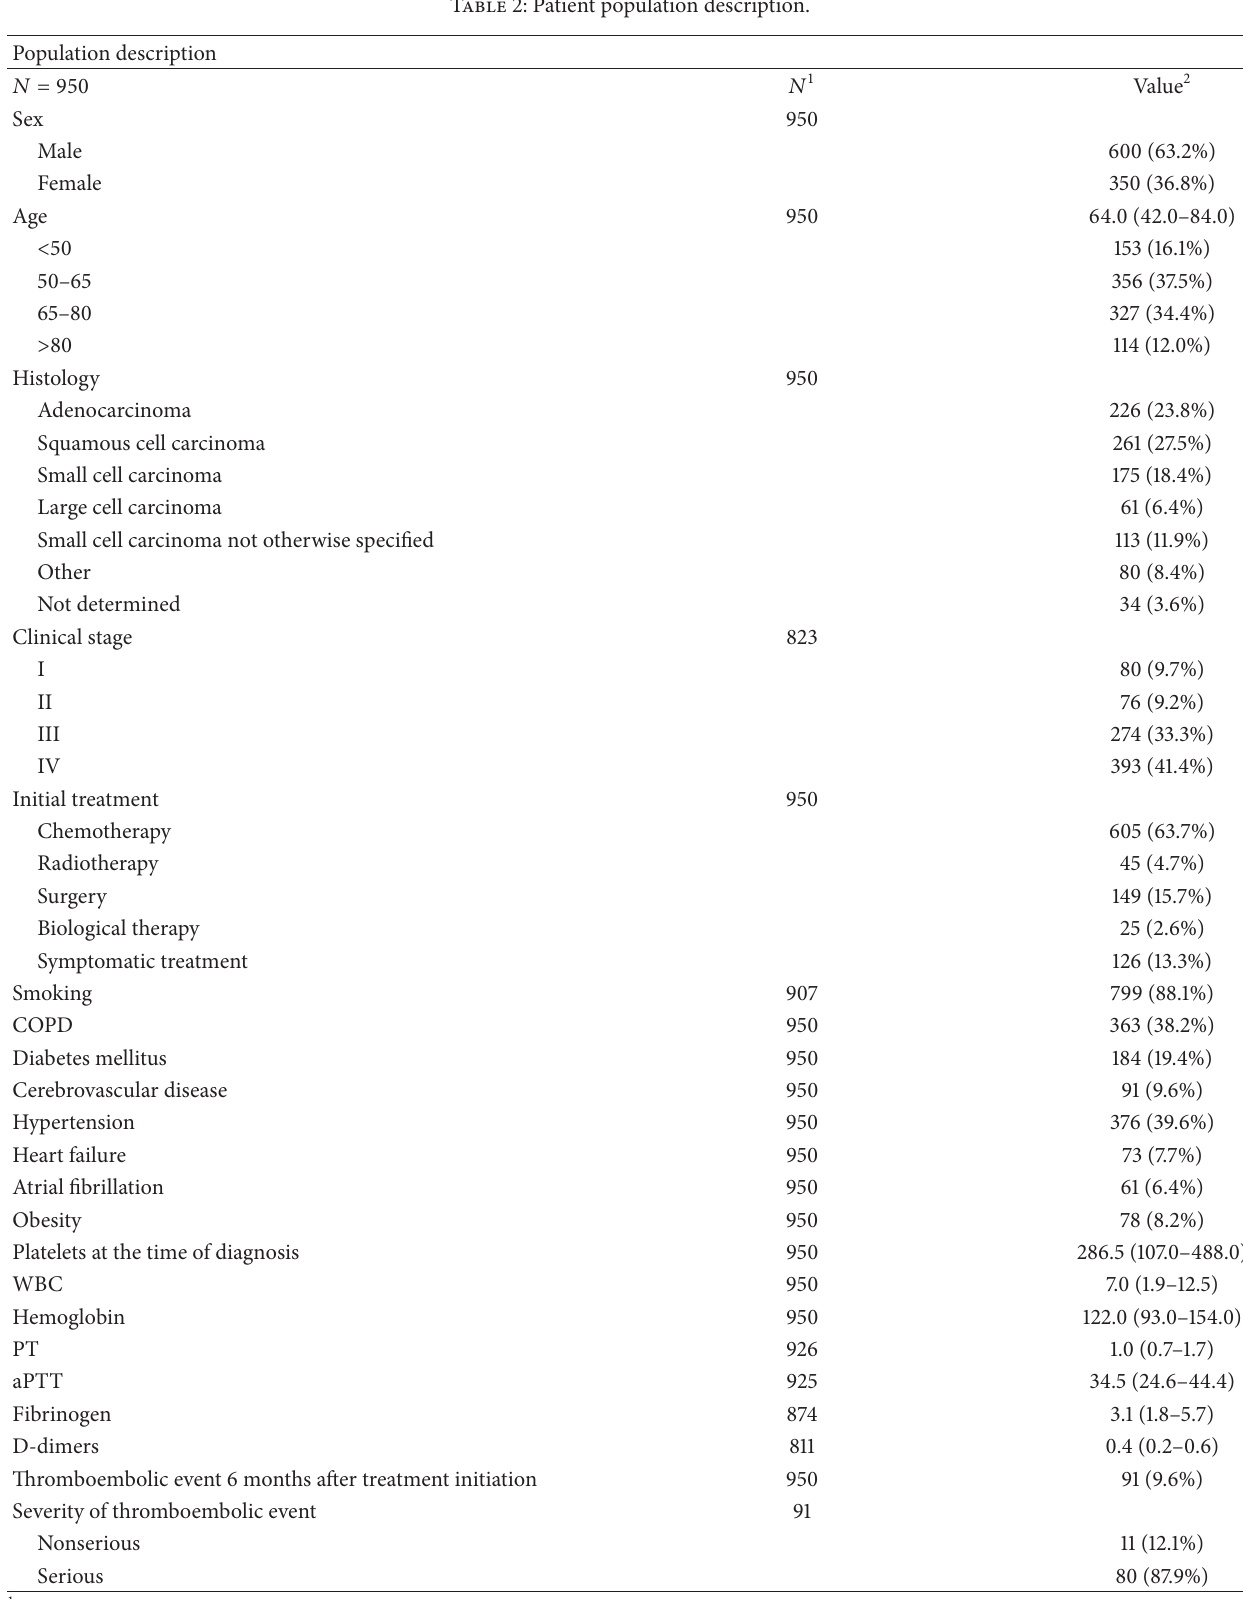
Table 2: Patient population